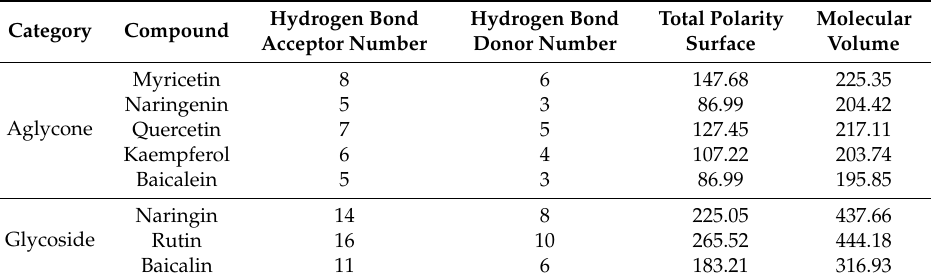
Table 3. The hydrogen bond number, total polarity surface and molecular volume of aglycone and glycoside flavonoids determined by molecular modeling.